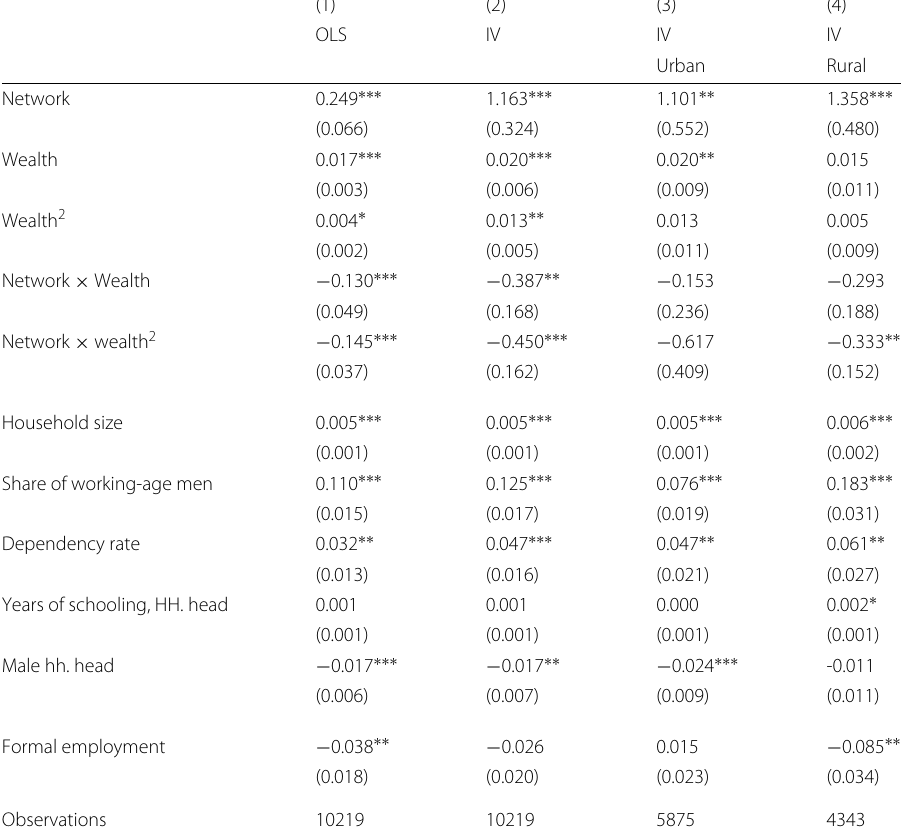
Table 11 Household determinants of the probability to send a migrant (1) (2) (3) (4) OLS IV IV IV Urban Rural 0.249